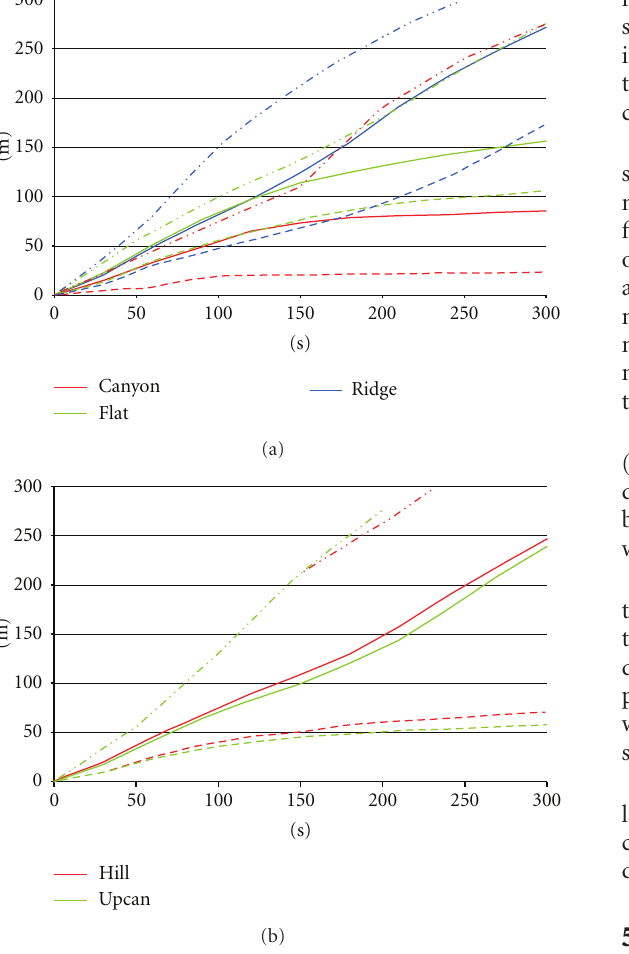
Figure 8: Propagation distance of the fire front function of time for the Canyon, Flat, Ridge cases (a) and Upcan, Hill cases (b). Firetec results are represented in dashed-dotted lines, while uncoupled results are shown by dashed lines and coupled results in plain